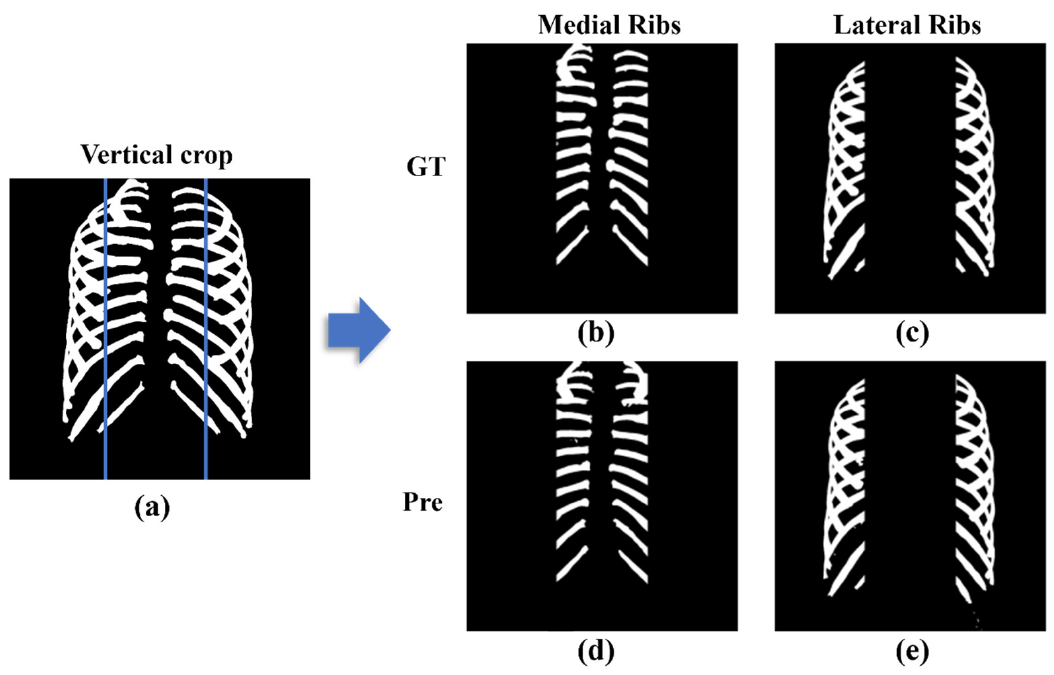
Figure 5. Vertical crop image divided into medial and lateral based on spine: ( a ) Entire rib image before cropping; ( b ) Ground truth images of medial ribs; ( c ) Ground truth images of lateral ribs; ( d ) Predicted images of medial ribs; and ( e ) Predicted images of lateral ribs.